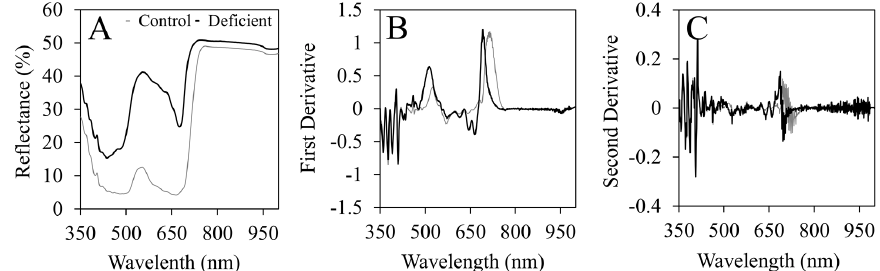
Figure 2. Graphs illustrating ( A ) the average spectral reflectance from 350 to 1000 nm for severely N-deficient flue-cured tobacco ( Nicotiana tabacum L.) compared to the average control spectra, ( B ) the first derivatives of the N-deficient and control spectra, and ( C ) the second derivatives of the N-deficient and control spectra.